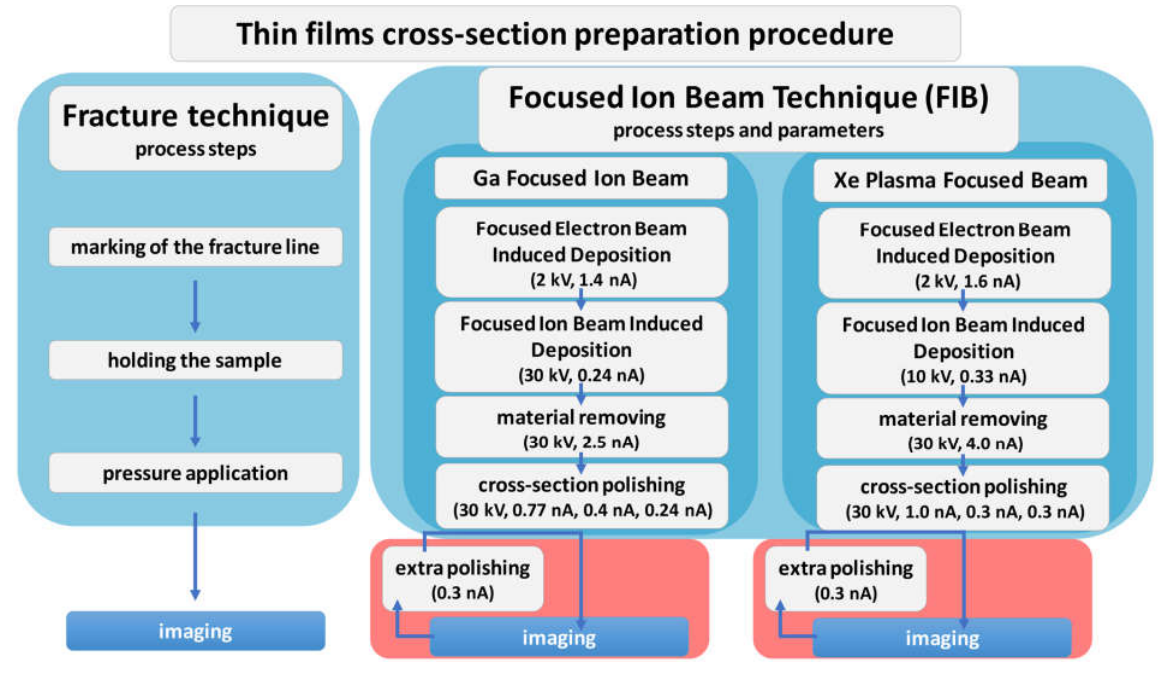
Figure 1. Cross-sectional preparation and SEM imaging procedure of thin-film multilayers. Fracture of the sample: in this procedure, the line of the breakthrough was marked on the sample (from a side of the silicon substrate) with a diamond stylus. Then, one end of the specimen was held, while the other was pressed with a laboratory spatula (perpendicular to the surface), causing a break along the plotted line. The breakthroughs prepared in this way were placed in an SEM holder in the form of a vise, allowing imaging perpendicular to the plane of the breakthrough, and ensuring proper charge dissipation and mechanical stability. For their microscopic visualization, a Helios NanoLab 600i SEM micro- scope was used equipped with a Schottky gun, with a claimed resolution of 1.4 nm @ 1 kV. The imaging was carried out in immersion mode, using a TLD detector, at an acceler- ation voltage of 2 kV and a current of 0.17 nA.